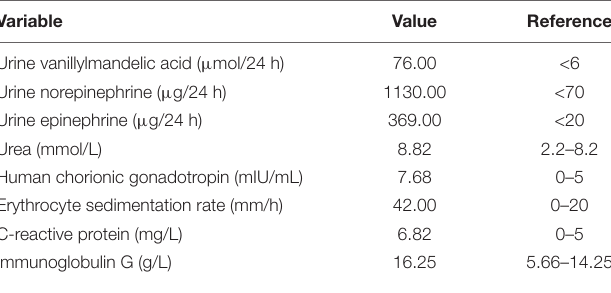
TABLE 1 | Results of laboratory test with reference